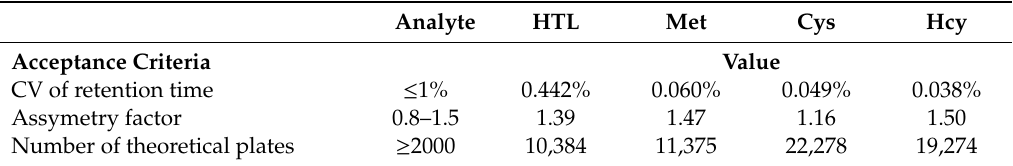
Table 2. System suitability test ( n =